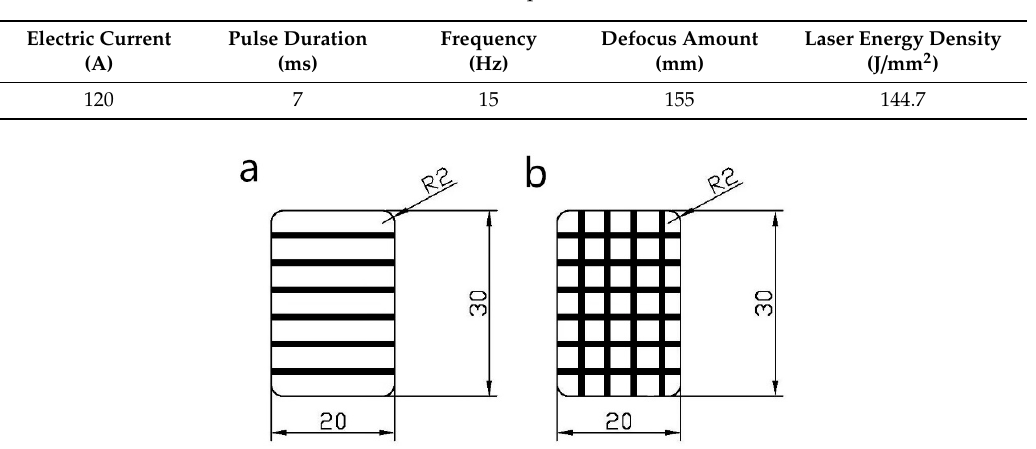
Figure 4. Linear reciprocating sliding friction and wear tester.